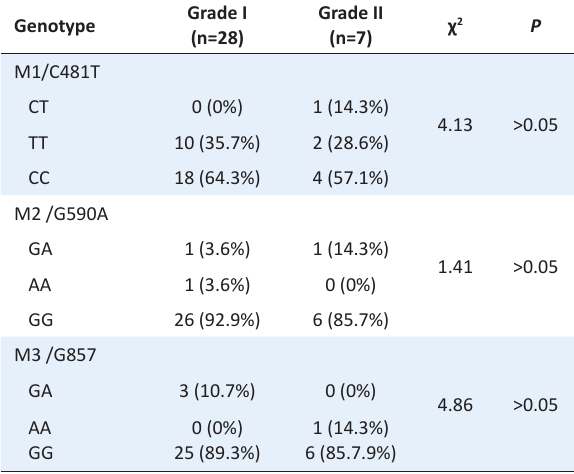
Table 4. Statistical comparison of NAT2 gene polymorphism (M1, M2 and M3) among different grades of bladder cancer patients using chi-square test